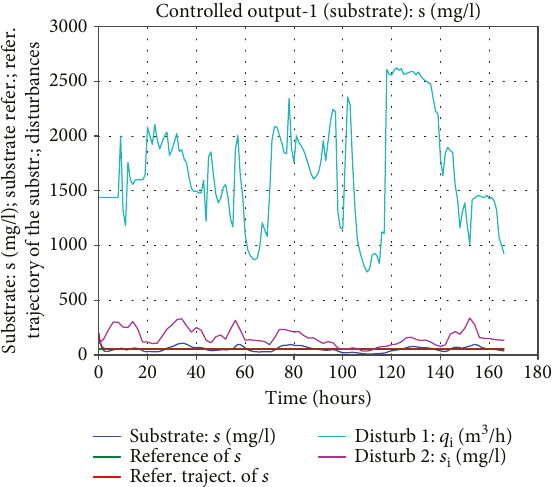
Figure 16: Substrate in the e ffl uent and disturbances (case B).